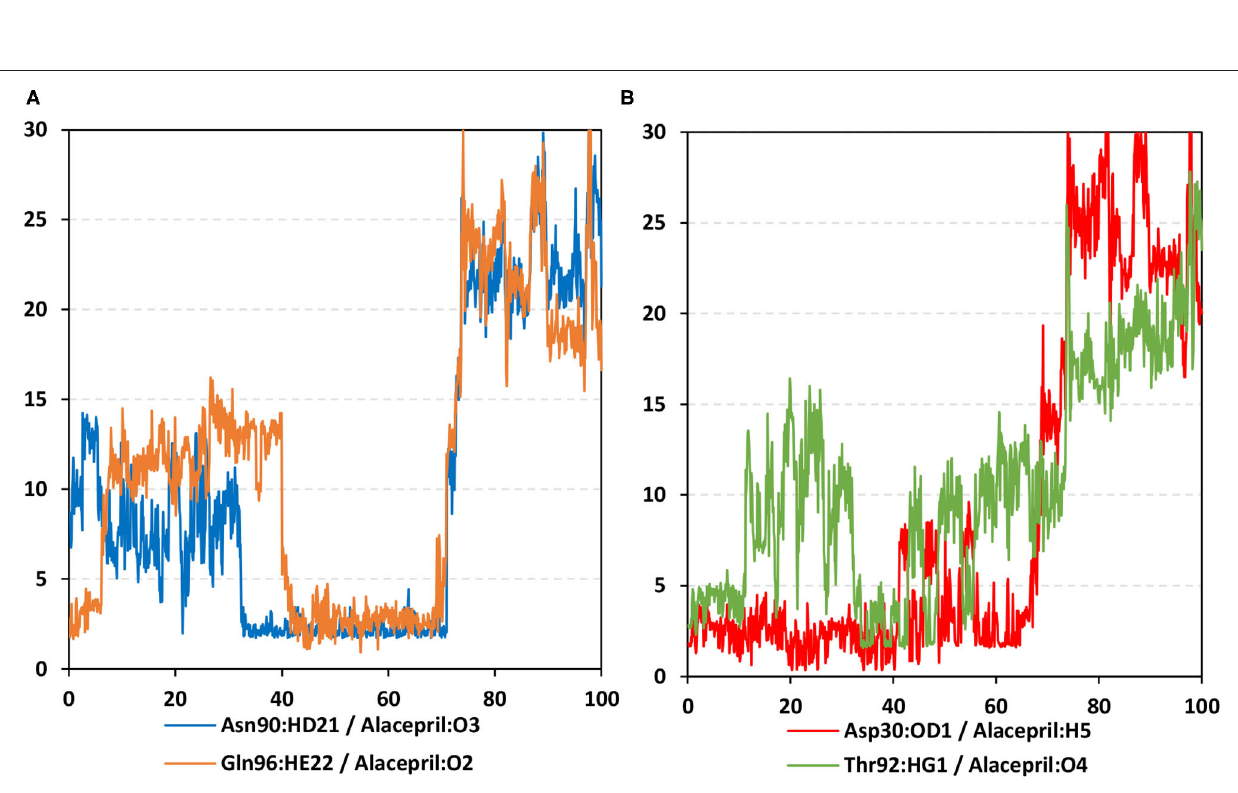
Frontiers in Chemistry |